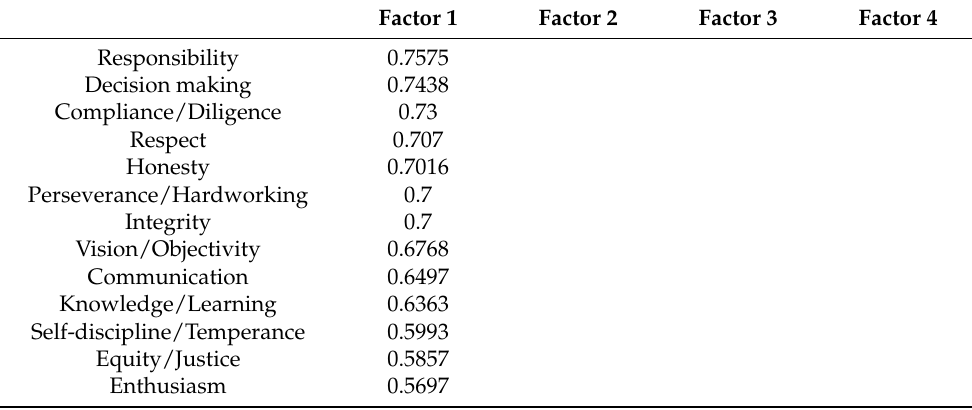
Table 7. Composition of factors of the ethical values present in